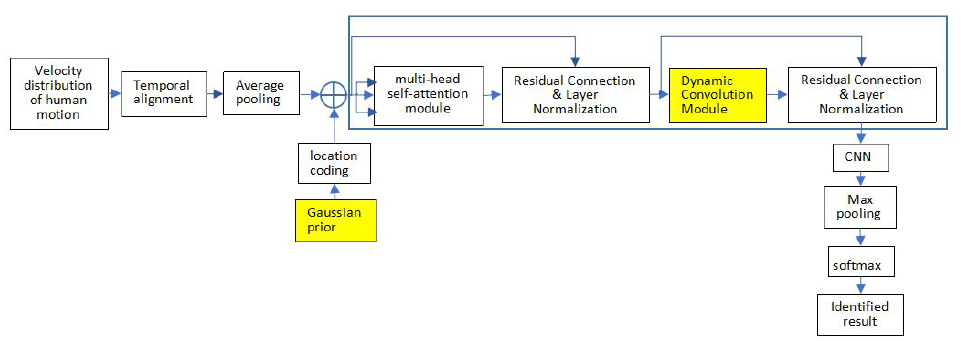
Figure 3. Convolutional Feature Augmentation Transformer Model